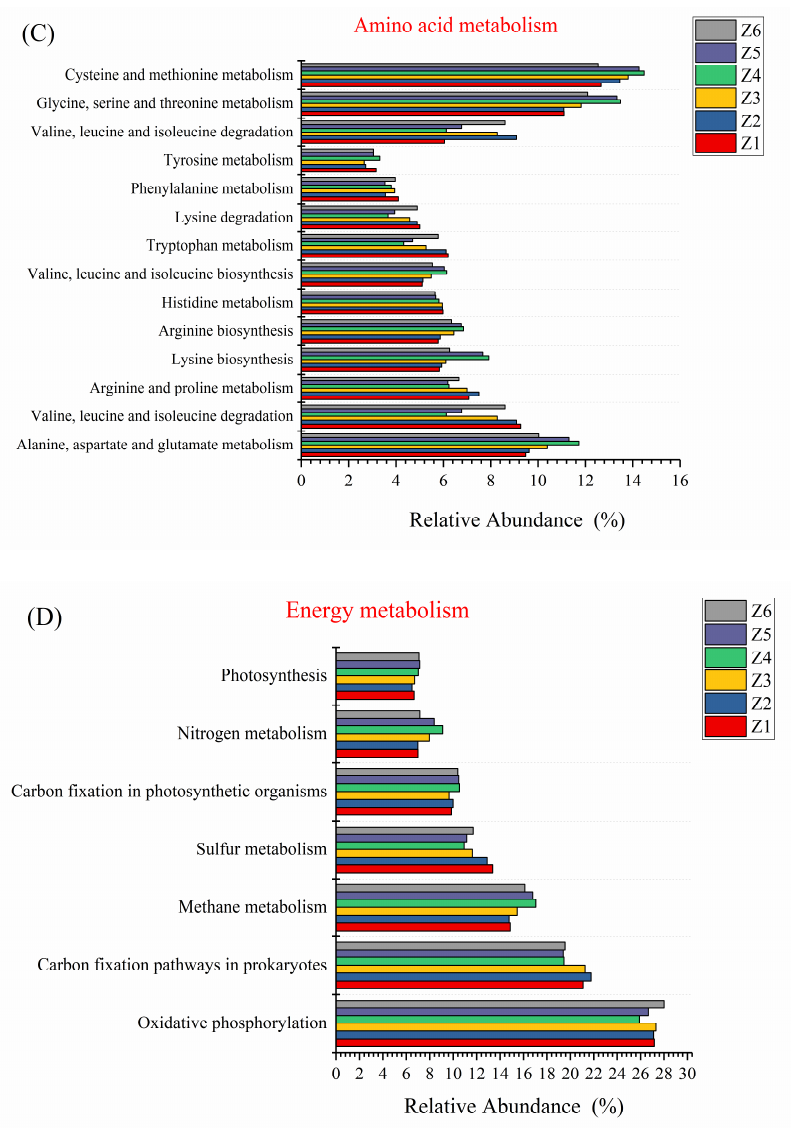
Figure 5. Variation in bacterial function profiles of BSFL at the level 2 ( A ) and level 3 ( B – D ) KEGG ortholog function predictions analyzed by PICRUSt. Z1, Z2, Z3, Z4, Z5, and Z6 represent the 6 experimental groups of 0, 50, 100, 200, 300, and 400 mg/L mixed flocculant,